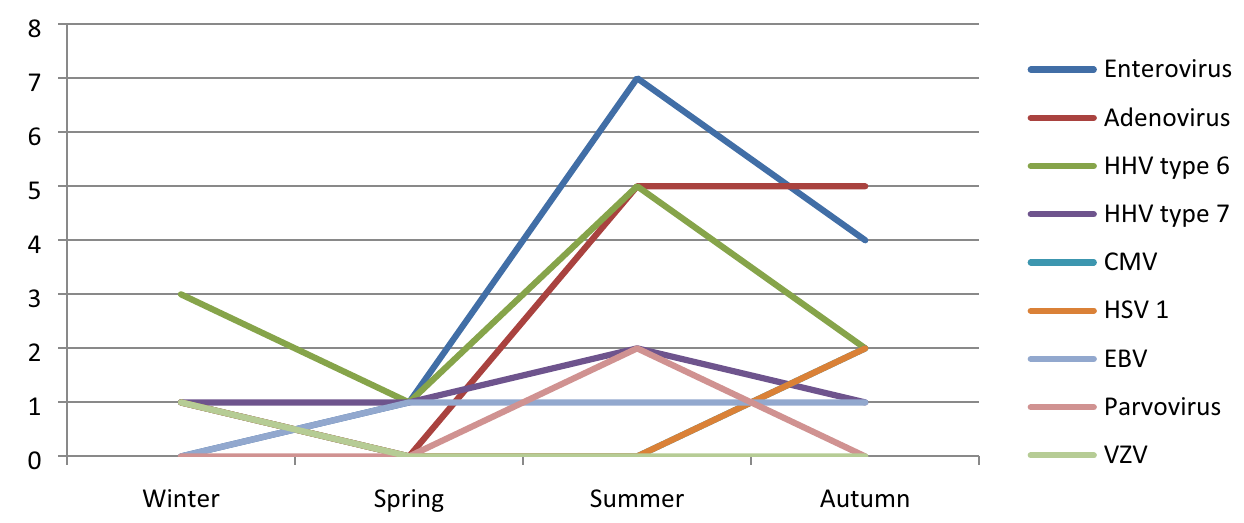
Figure 2. Application seasons of patients who are positive as a result of viral panel. HHV Human Herpes Virus, CMV Cytomegalovirus, HSV Herpes Simplex Virus, EBV Ebstein Barr Virus, VZV Varicella Zoster Virus.